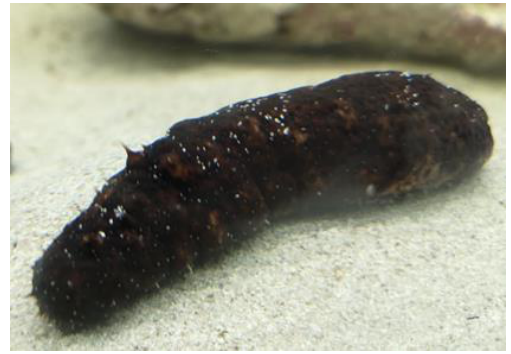
Figure 1. A specimen of Holoturia tubulosa sea cucumber .